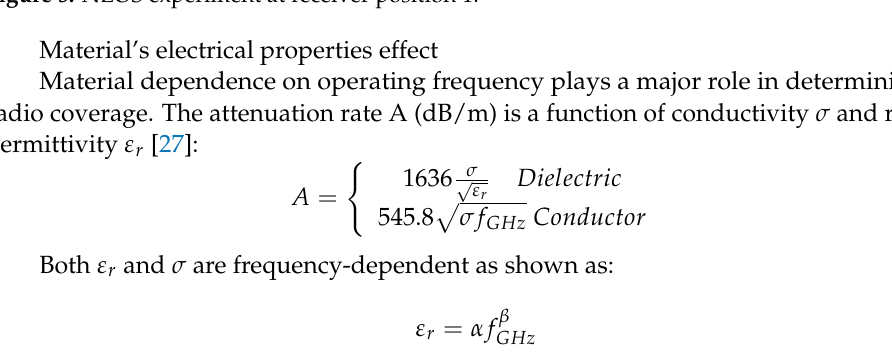
Figure 5. NLOS experiment at receiver position